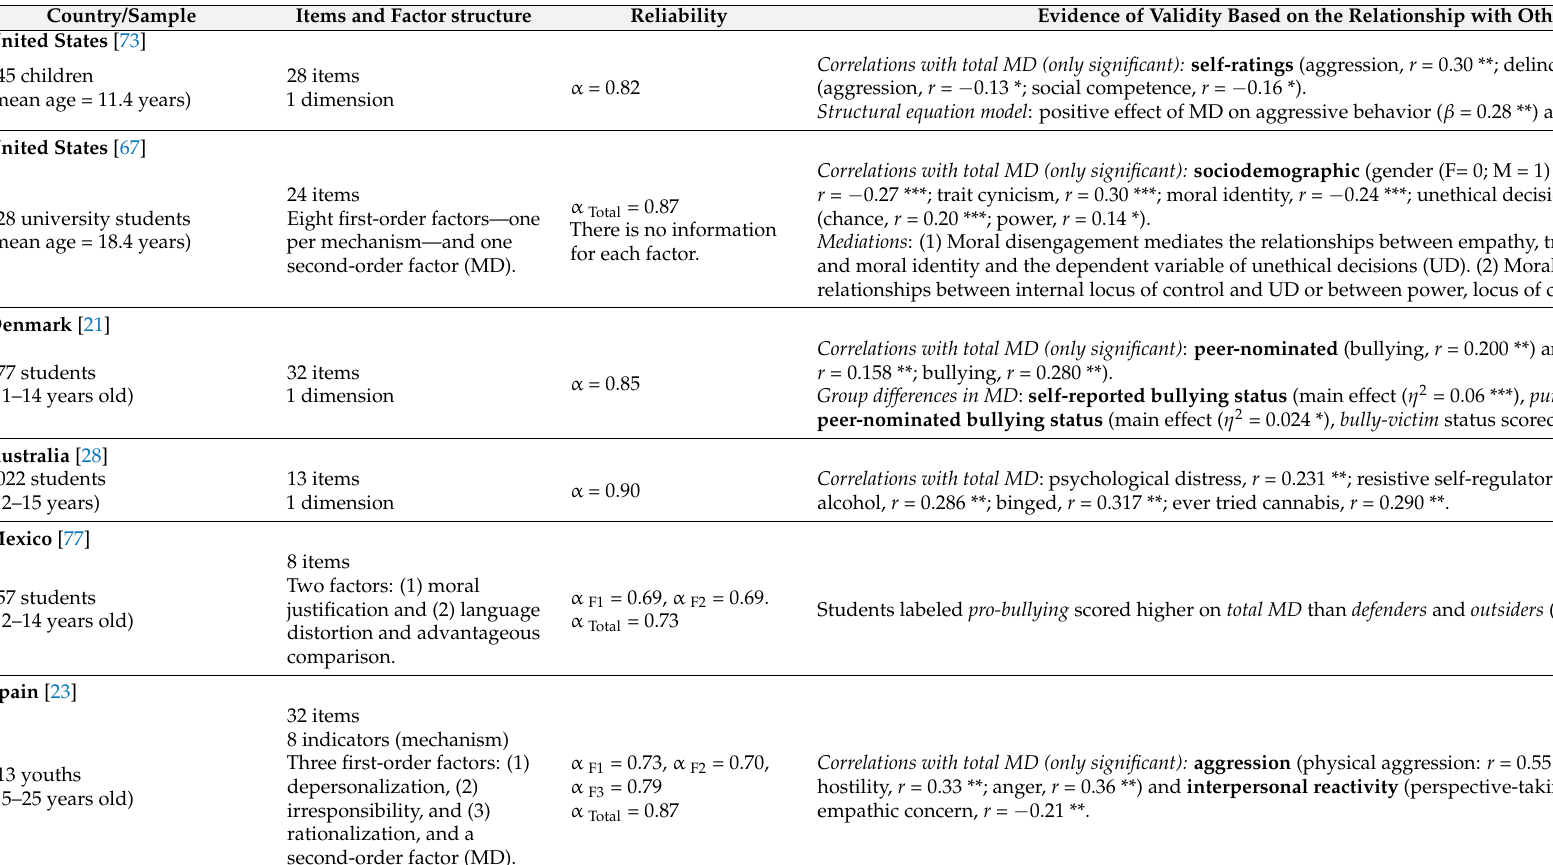
Table 1. Psychometric properties of the MMDS in children, adolescents, and young people from different